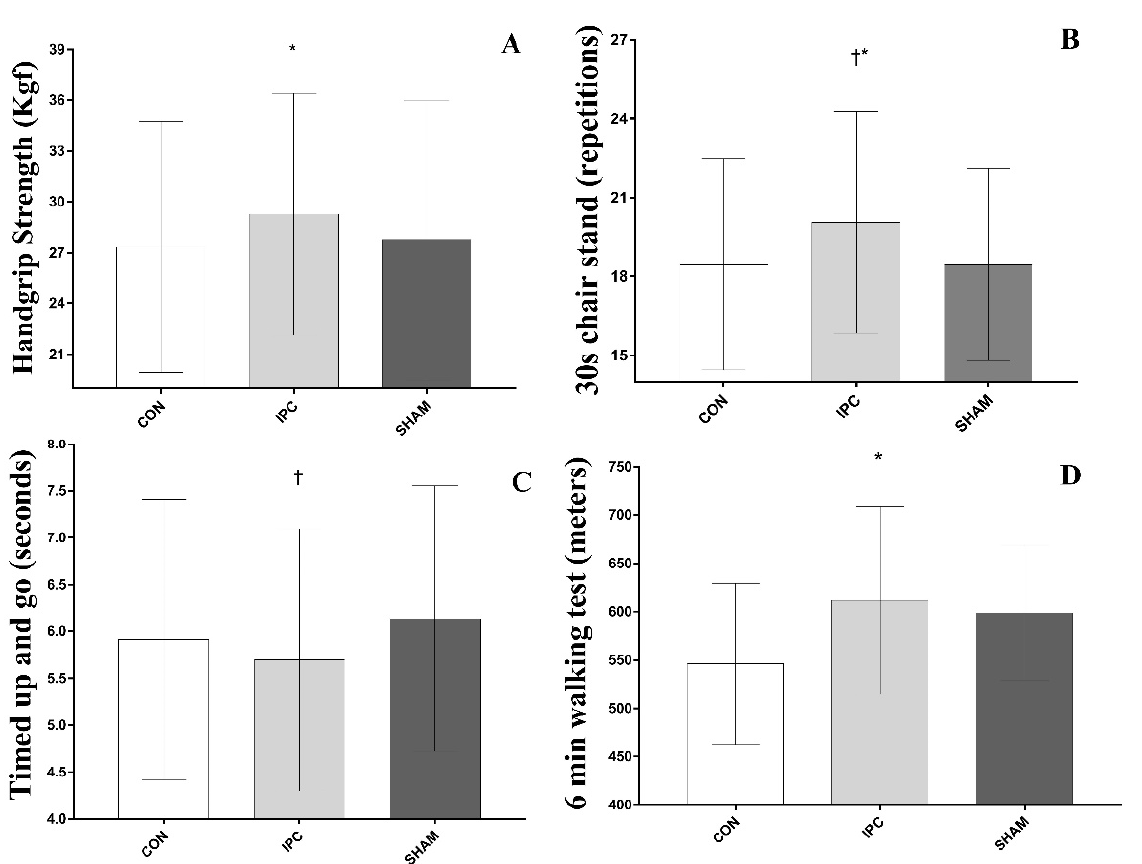
Figure 2. ( A ) handgrip strength; ( B ) 30 s chair stand; ( C ) timed up and go; ( D ) 6 min walking test * Significant differences with IPC vs.; † Significant differences with IPC vs. SHAM.